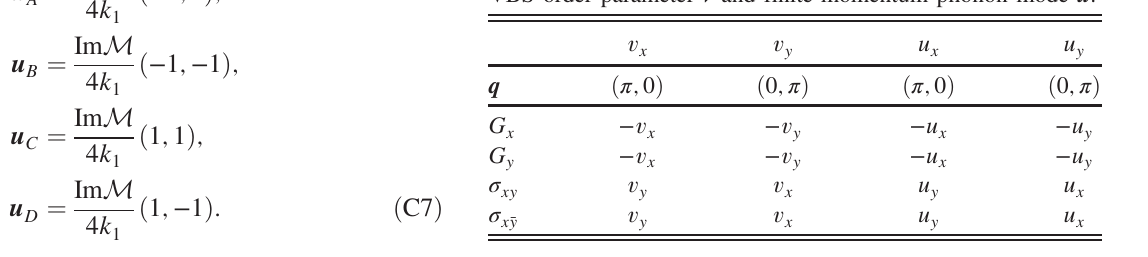
TABLE VII. Momentum and symmetry transformations of the VBS order parameter v and finite-momentum phonon mode u